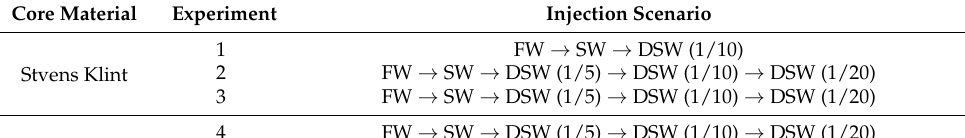
Table 4. Injection sequences and scenarios of core flooding experiments. Core